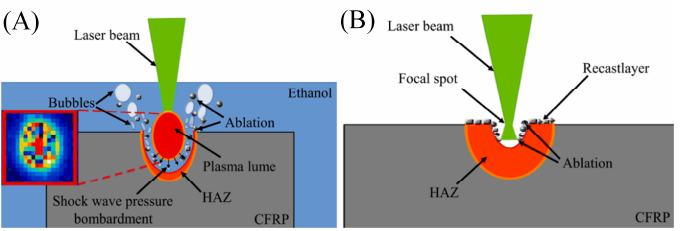
Figure 8. Laser-induced plasma micro-drilling method versus conventional laser processing: ( A ) schematic of LIPMD process; ( B ) schematic of LIA process [49].